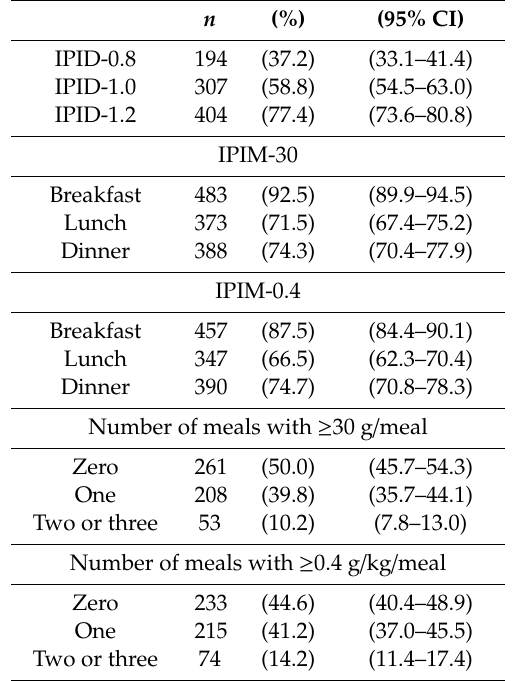
Table 3. Combined data ( n = 522) from the four samples